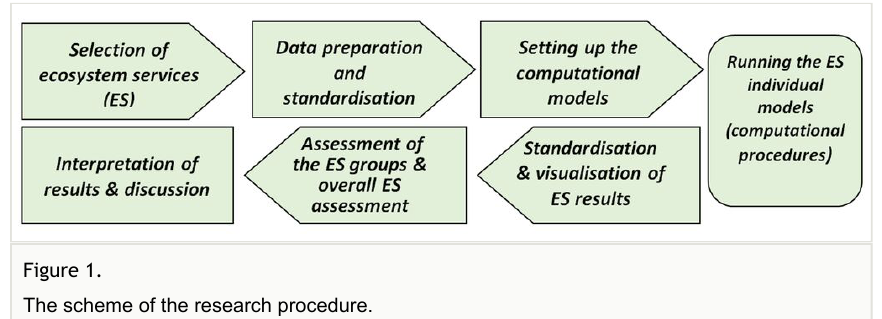
The scheme of the research procedure.